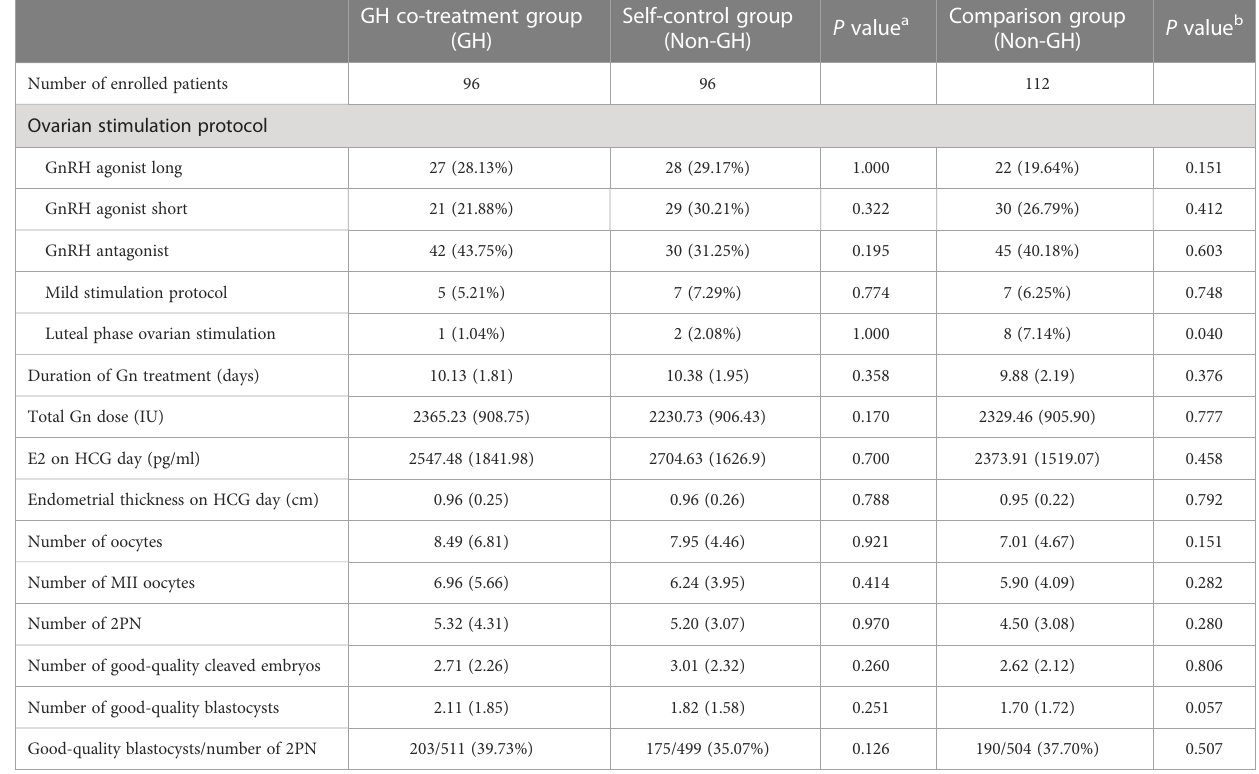
TABLE 2 Comparison of parameters during the ovarian stimulation and embryonic